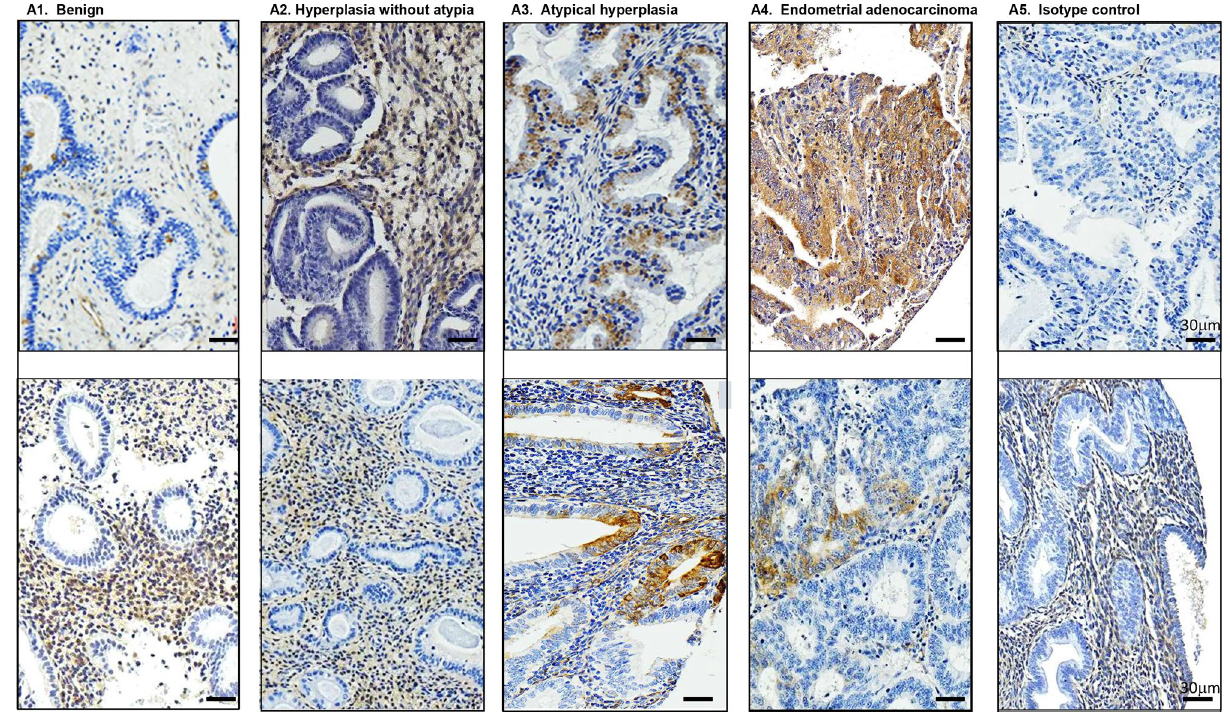
Figure 4. ALDH1 is expressed in premalignant endometrium. Immunohistochemical staining from representative cores of two patients per histology is shown. Within the endometrium, ALDH1 predominantly displayed a cytoplasmic distribution in glandular epithelium with some expression observed in the stroma. Magnification = 100X. Scale bar = 30 µm.